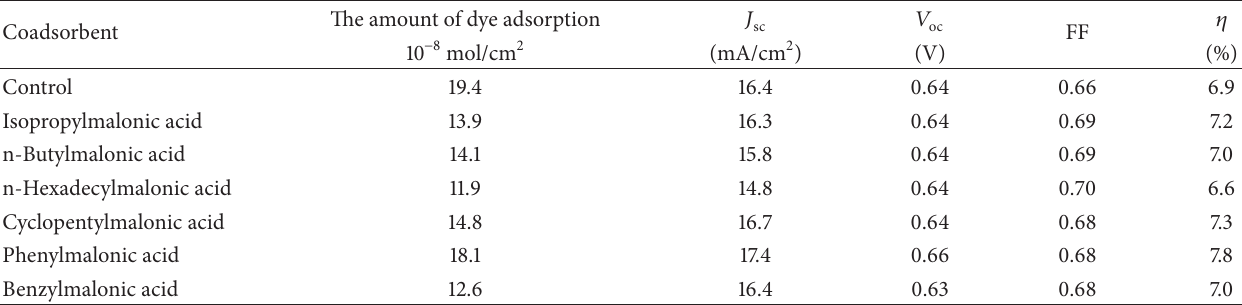
Table 1: Photovoltaic parameters of DSC devices with malonic acid derivatives.